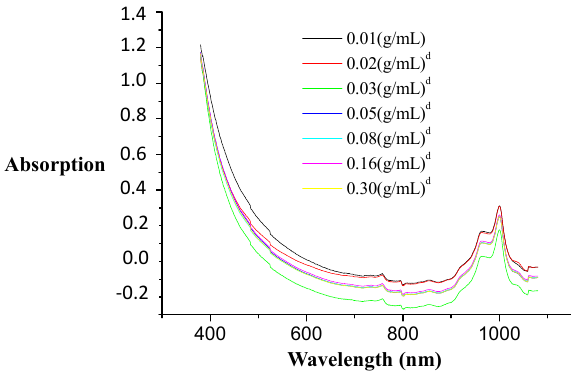
Figure 8. Spectra of the extracted solution (ES) at different Xi (T = 25 °C/stirring rate = 50 rpm/extraction time = 72 h/20.0 mL ammonia solution (25%)/batch experiment). “d”: after proper dilution.